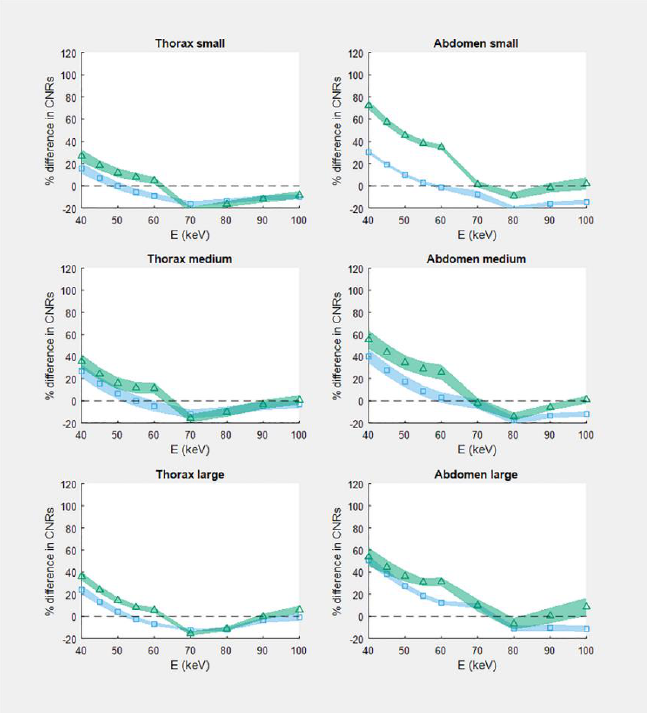
Figure A1. Relative CNR in virtual monoenergetic images reconstructed with iterative reconstruction (IR) technique as a function of energy E (keV). For each phantom and energy, CNR of the PCD-based system (with 50% IR strength) is presented relative to the CNR of the EID-based system (with 60% IR strength). Squares: single-energy 120 kVp PCD-CT. Triangles: single-energy 90 kVp PCD-CT. Symbols depict the estimated value and the accompanying shaded boundaries depict the standard error of this estimate.